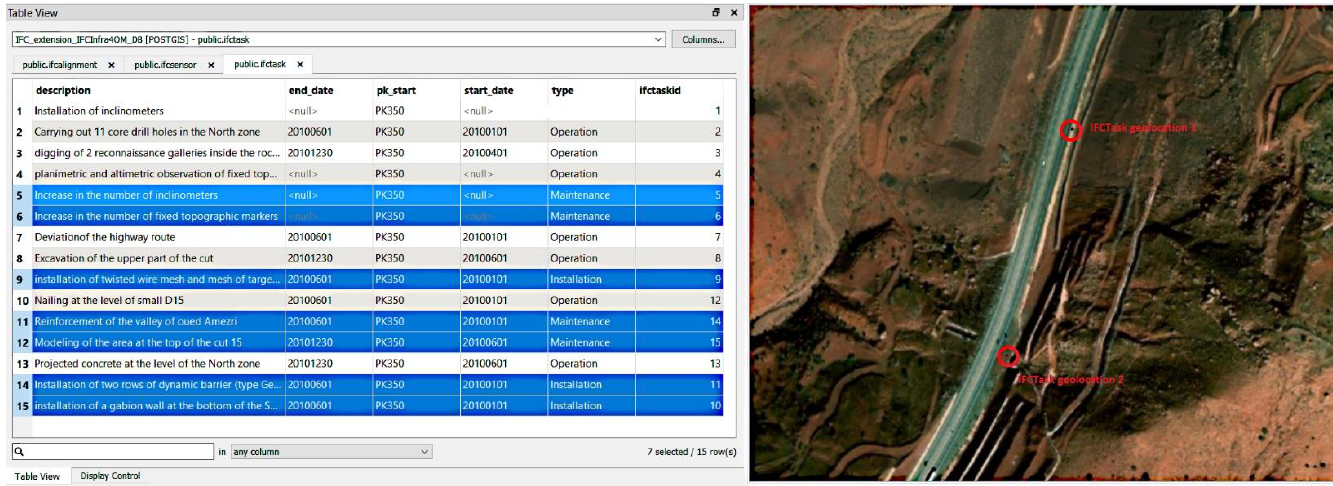
Figure 12. Example of the result of the multi-filter queries: IFCTask installation and maintenance type extracted and geolocated on the IFCAlignment.